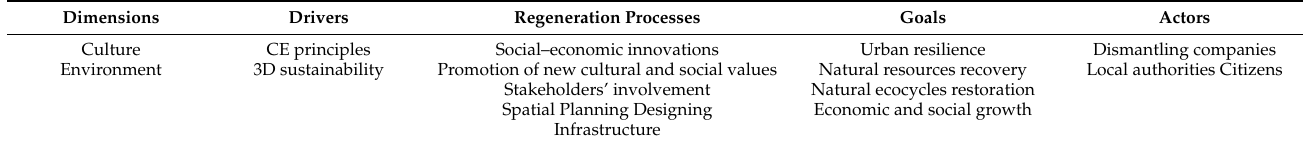
Table 1. Circular urban regeneration framework for recycling wind